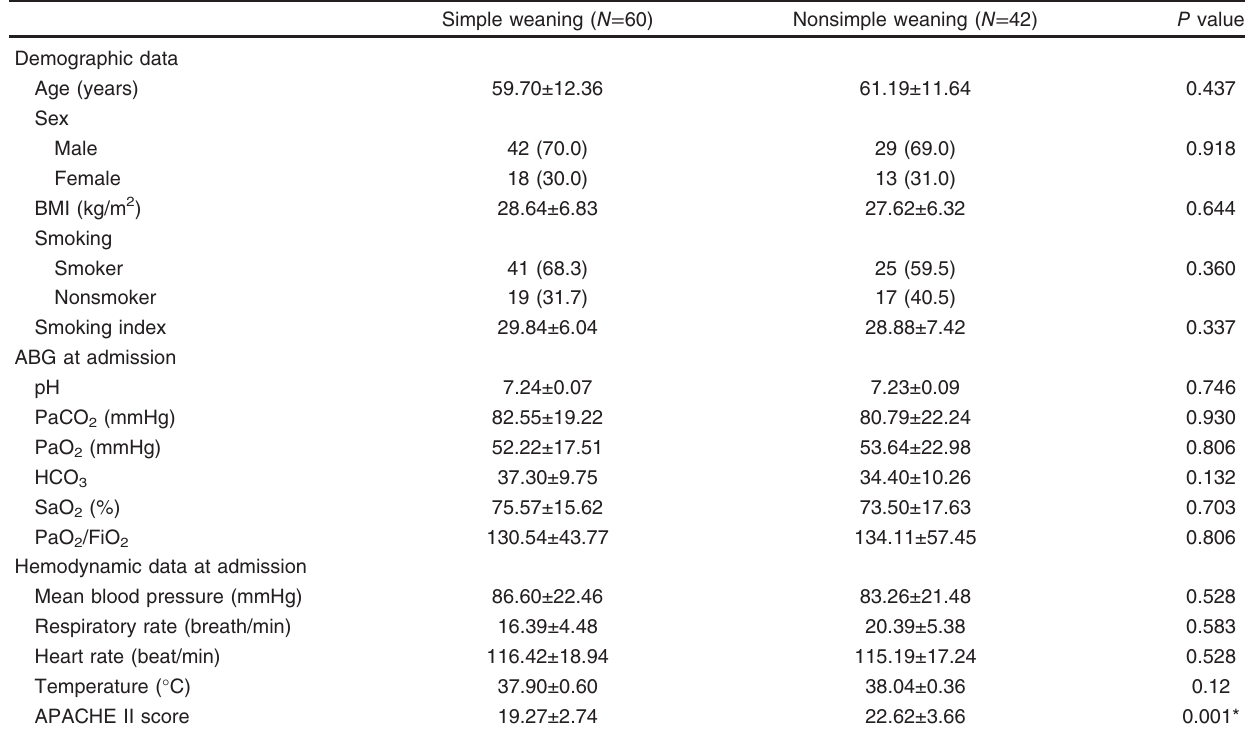
Table 1 Demographic data and patient characteristics for the studied groups Simple weaning ( N = 60)